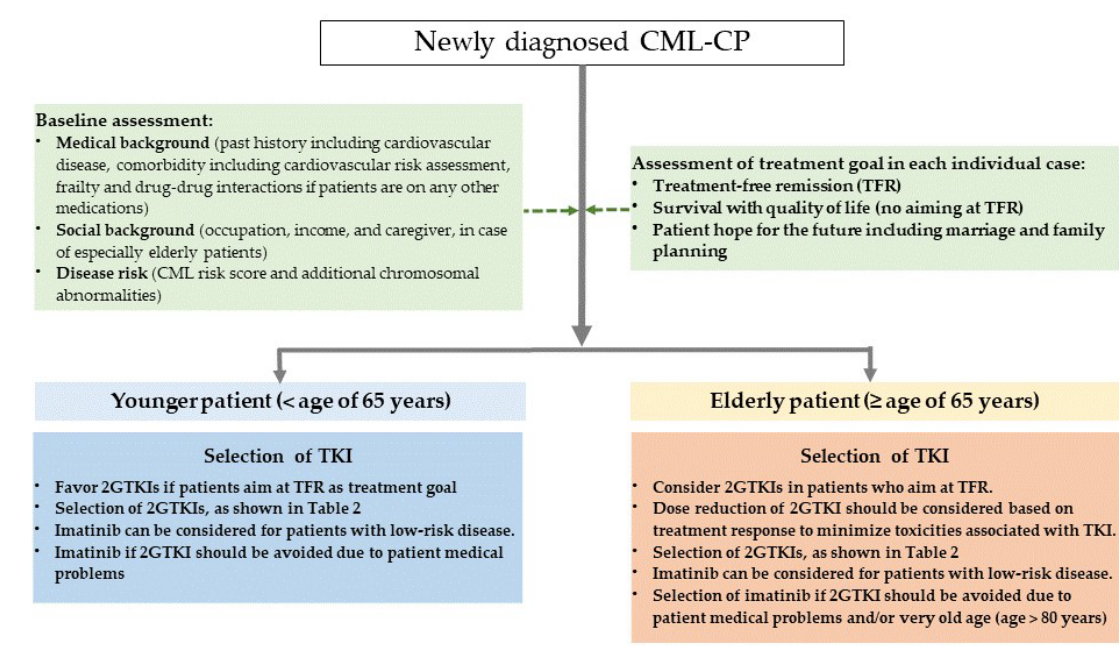
Figure 1. Suggestion for TKI selection for first-line treatment in patients with newly diagnosed